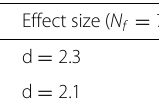
Table 2 Assessment outcomes by assigned condition Condition